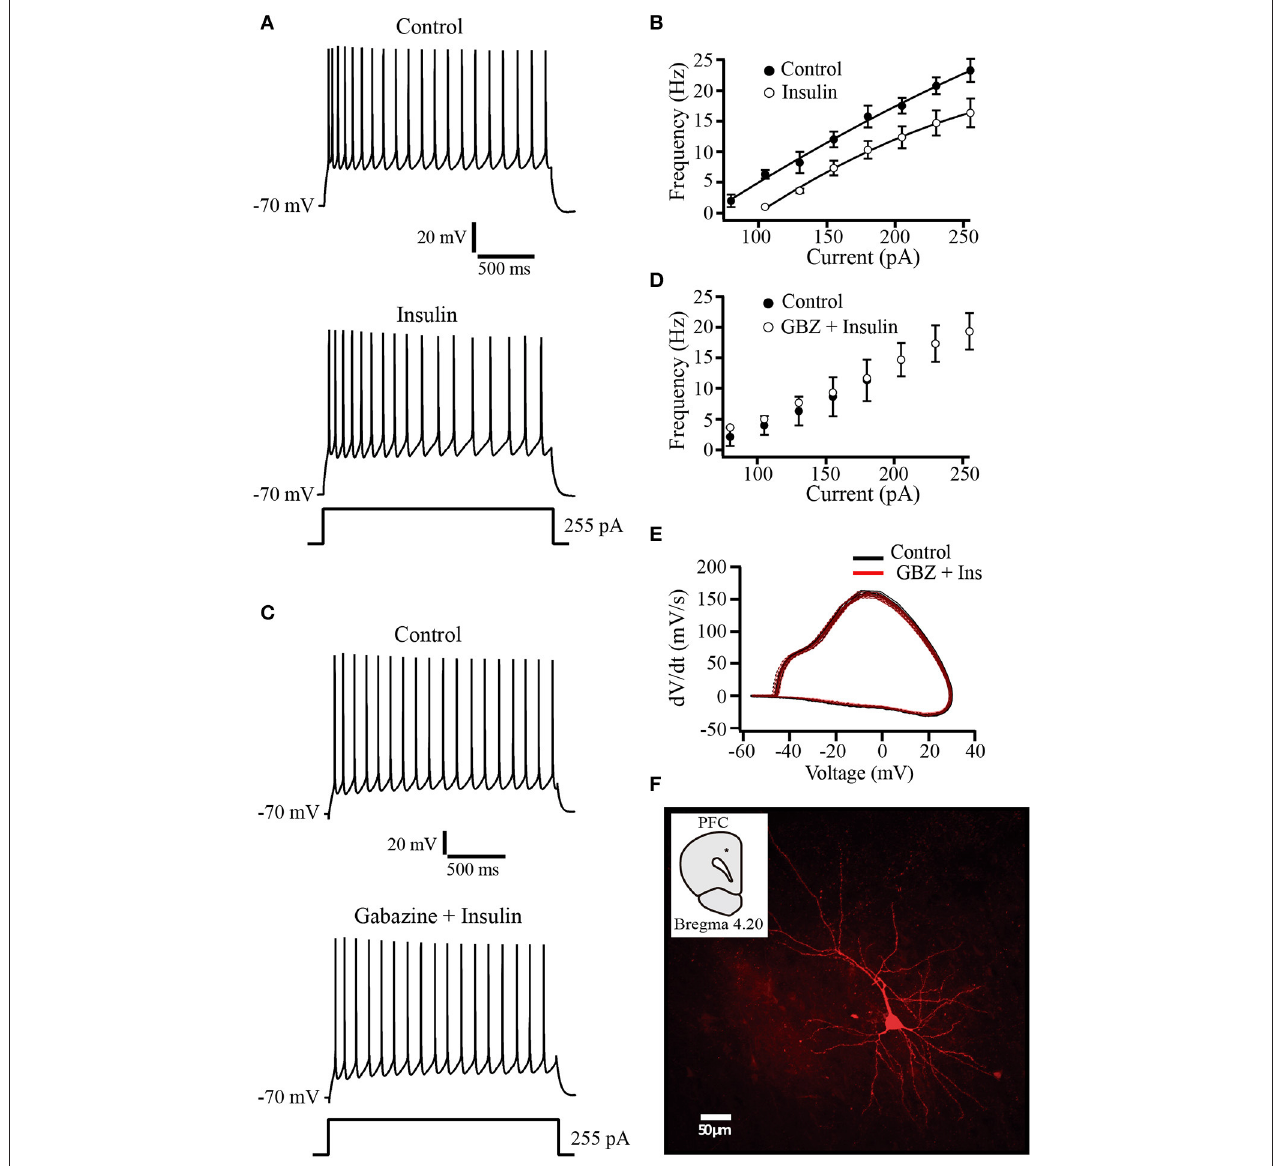
FIGURE 5 | Insulin decreases the firing frequency evoked by depolarizing current injection. (A) Current clamp recordings in control (top) and insulin (500nM, bottom) showing the response to a depolarizing current injection of 255pA. Note that following insulin incubation, the frequency of action potential is decreased (bottom trace). (B) Current-frequency relationship in control and insulin conditions (top) ( n = 5). (C) Current clamp recordings in control (top) and insulin plus gabazine (GBZ, bottom). Insulin has no effect on the firing frequency in the presence of gabazine ( n = 6) (bottom trace). (D) Current-frequency relationship of control (filled circles and insulin plus gabazine (empty circles, top). (E) Phase-plot analysis of the action potential for both conditions. Control (black line); gabazine (SR) plus insulin (red line). (F) Typical PFC pyramidal neuron labeled with biocytin. The inset shows the recording site (black